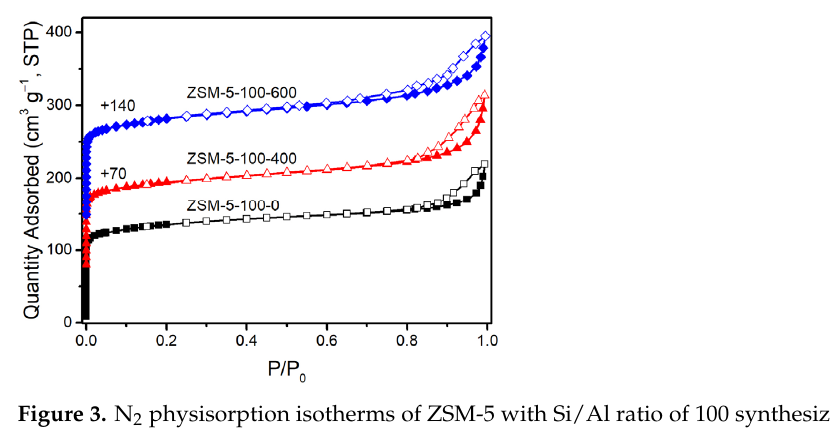
Figure 4. XRD patterns of ZSM ‐ 5 with different Si/Al ratios.